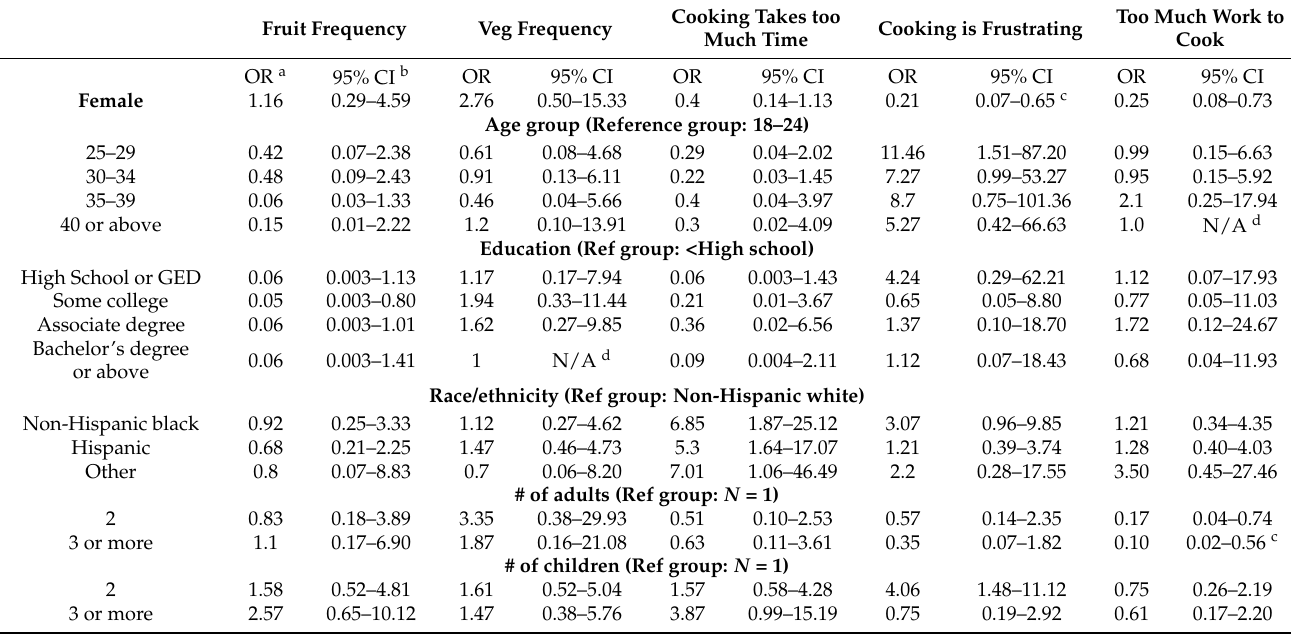
Table 3. Logistic regression results of improvement in eating behaviors and attitudes towards cooking among new Cooking Matters Facebook followers ( n = 167).